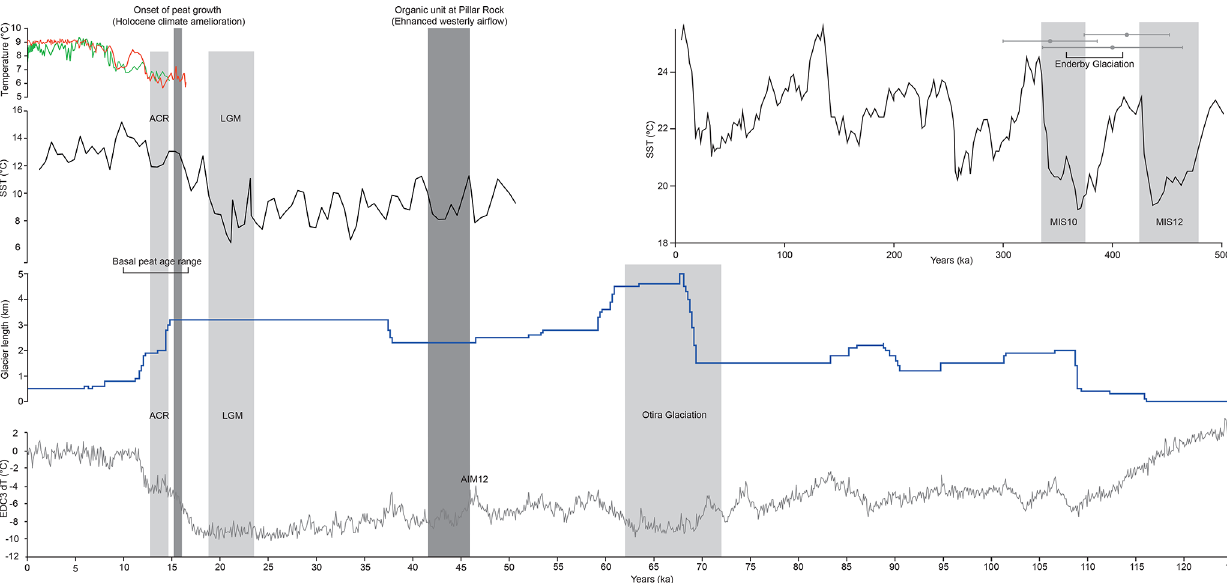
Figure 9. Plot showing key Pleistocene events on the islands. Organic growth at ∼ 46–41ka and onset of peat growth at 16.6ka are shown by dark grey bars against sea surface temperature reconstructions (Pahnke and Sachs, 2006) and EPICA Dome C δT (Parrenin et al., 2007). The ACR, New Zealand timing of the LGM, and the Otira Glaciation are highlighted by pale grey bars. Summer temperature reconstructions from Campbell Island (McGlone et al., 2010) are shown in green (Mount Honey) and red (Homestead Scarp), highlighting minimal ACR temperature depression over the islands despite the strong SST and EPICA Dome C expressions. Bracket shows spread of basal radiocarbon dates. Modelled glacier length is shown in blue. Inset shows samples Enderby-1, Enderby-2, and Enderby-4 against SST reconstruction (used as a proxy for the subtropical front) from Bard and Rickaby (2009), with weighted mean bracketed and MIS 10 and MIS 12 marked as grey